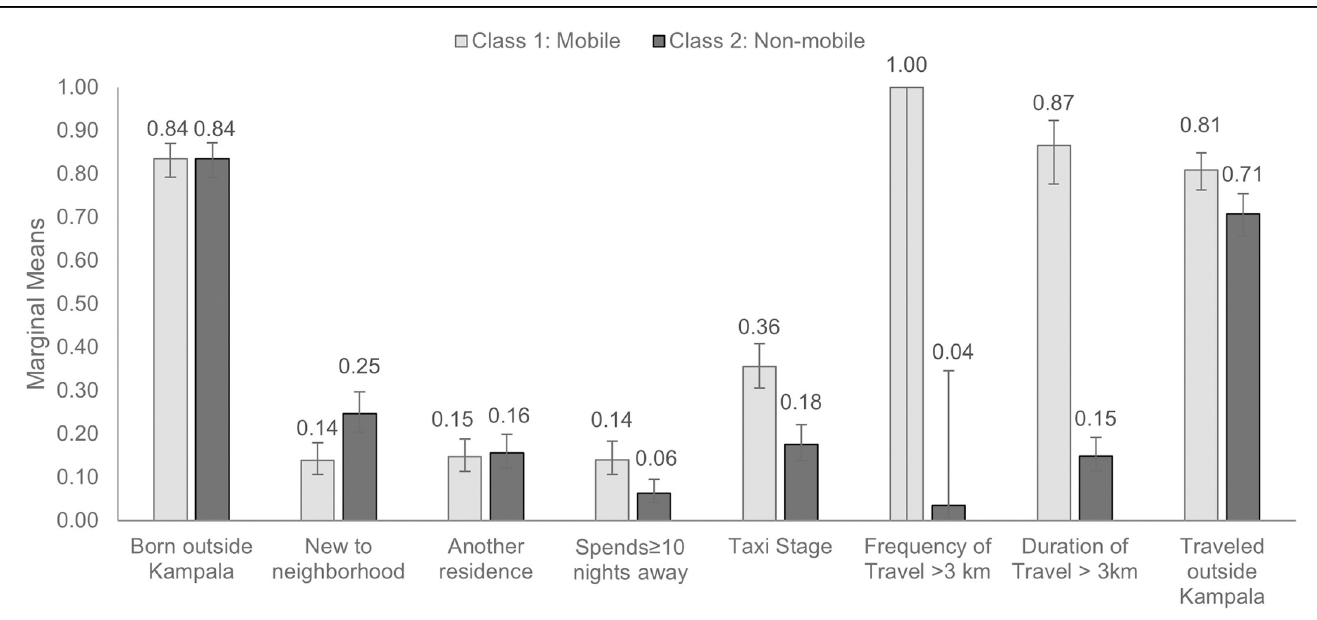
Fig 2. Marginal means for latent classes of mobility. The estimated mean for each observed item (of the eight observed varables) is shown for two latent classes: mobile and non-mobile. These values are also presented in S2 Table.